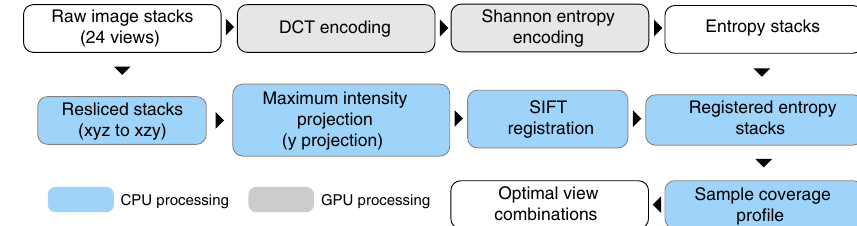
Fig. 4 The smart rotation work fl ow evaluation